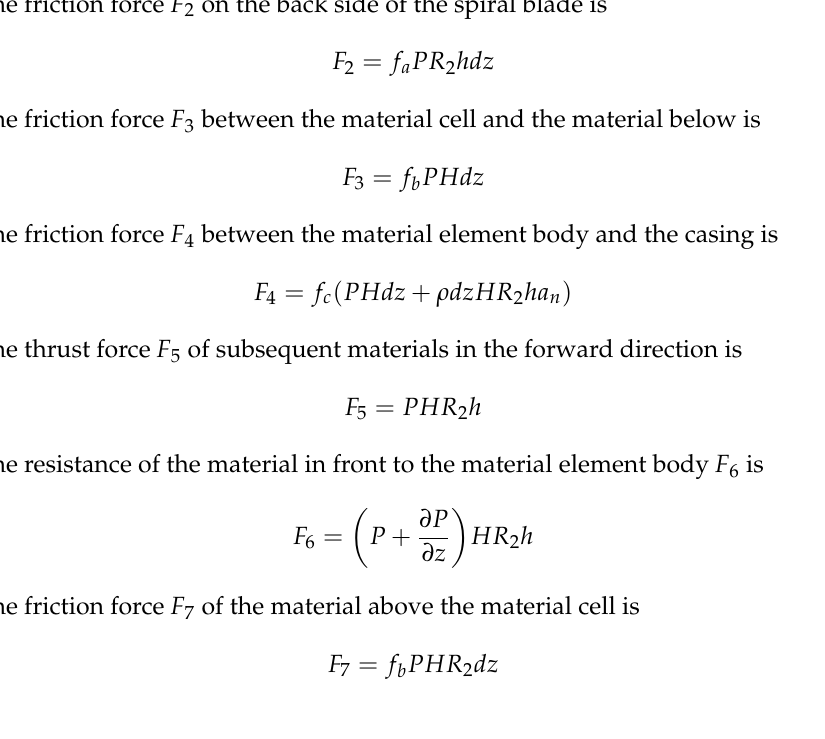
Figure 3. Schematic diagram of force on